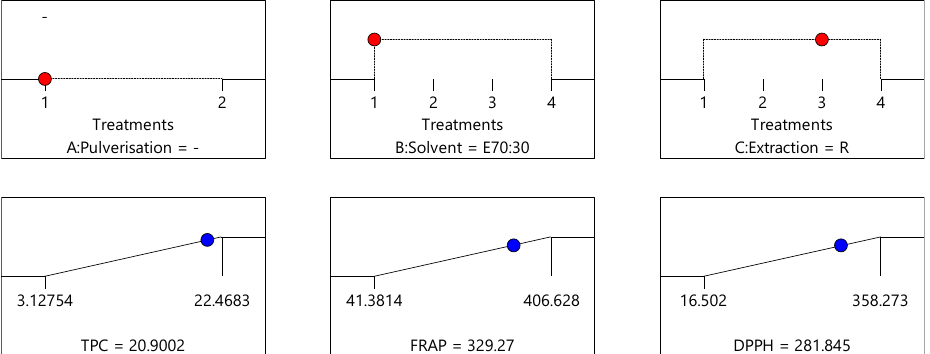
Figure 9. Proposed optimised extraction condition 3: crude/non-pulverised sample extracted using 70% ethanol:30% water (E70:30) and reflux (R), corresponding to the optimal conditions see in Figure 4 for TPC data, Figure 5 for DPPH data, and Figure 6 for FRAP data (desirability = 0.883). Based on the model, the crude/non-pulverised pollen sample, extracted with 70% ethanol:30% water (E70:30) by agitation (A) as the extraction process produced the highest desirability (0.92) (Figure 7), followed by the crude/non-pulverised pollen sample, ex-